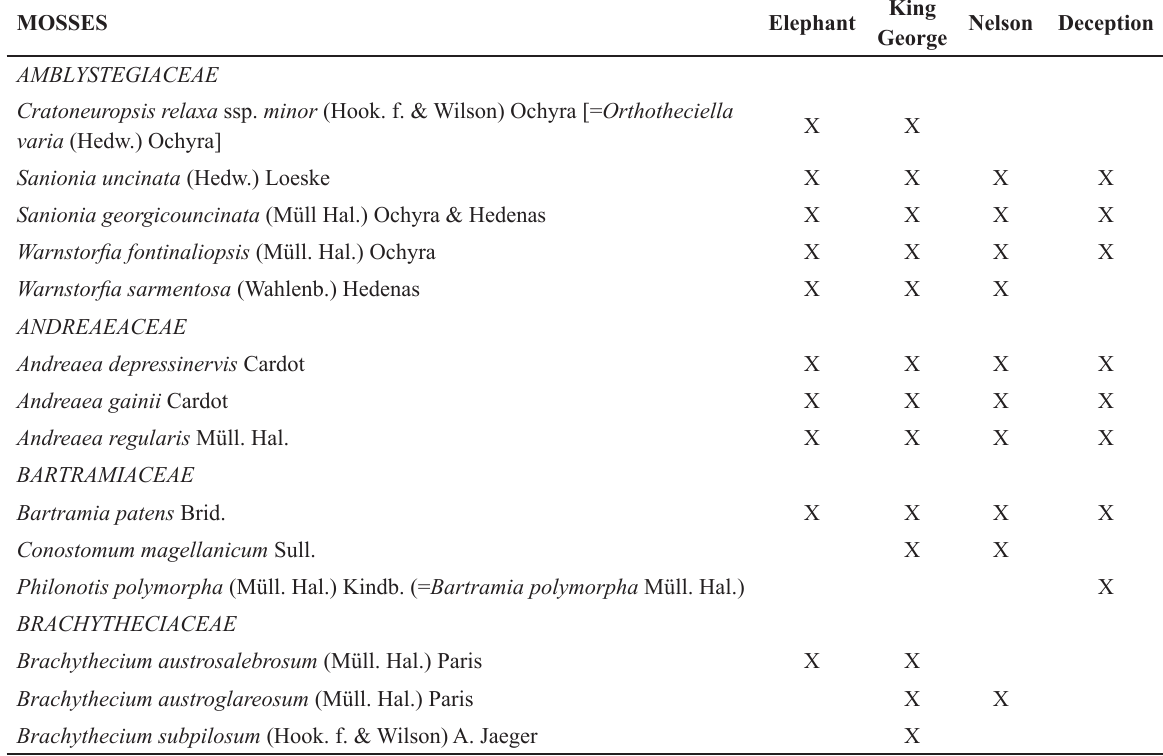
Moss species collected in the four South Shetland Islands by Brazilian